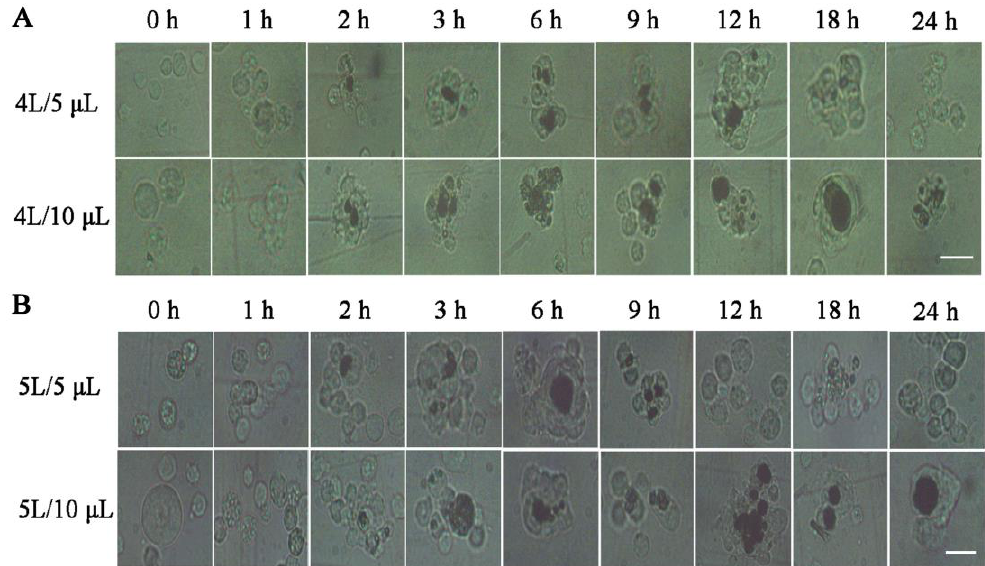
Figure 1. ( A ) The development of disease silkworm with melanin deposition on integument. Type 1: larvae with less pigment on the integument metamorphosed normally to pupae with the normal phenotype; type 2: larvae with more pigment pupated with a black body color, and died soon after pupation; type 3: larvae with the most pigment turned black, limp and died before pupation. ( B ) Hemocytes morphology corresponding to the larvae states in (A). The right column provides a close-up of the areas within the black boxes corresponding in the left column. The black boxes show the areas to zoom in on. The horizontal bar “ 一 ” represents 20 μm.